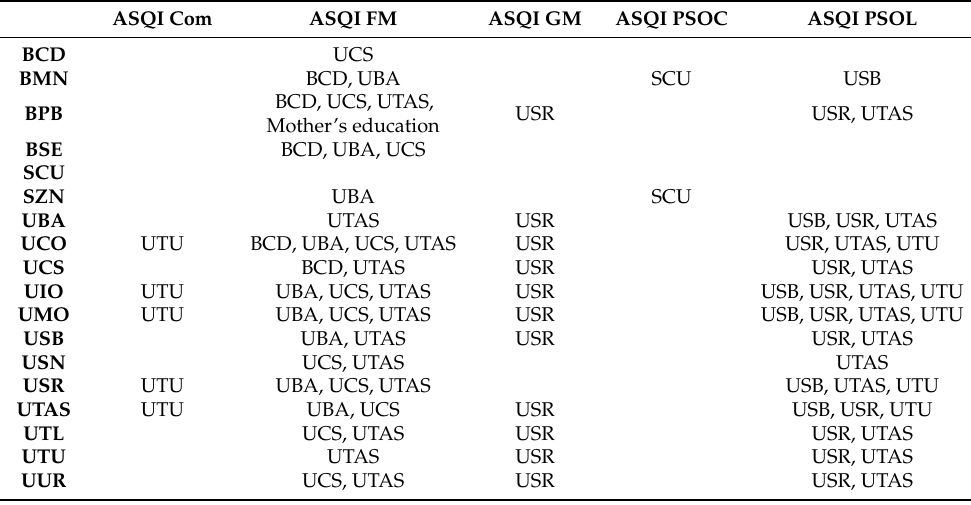
Table A1. The sets of control variables based on a threshold of 0.05 for the p -values.